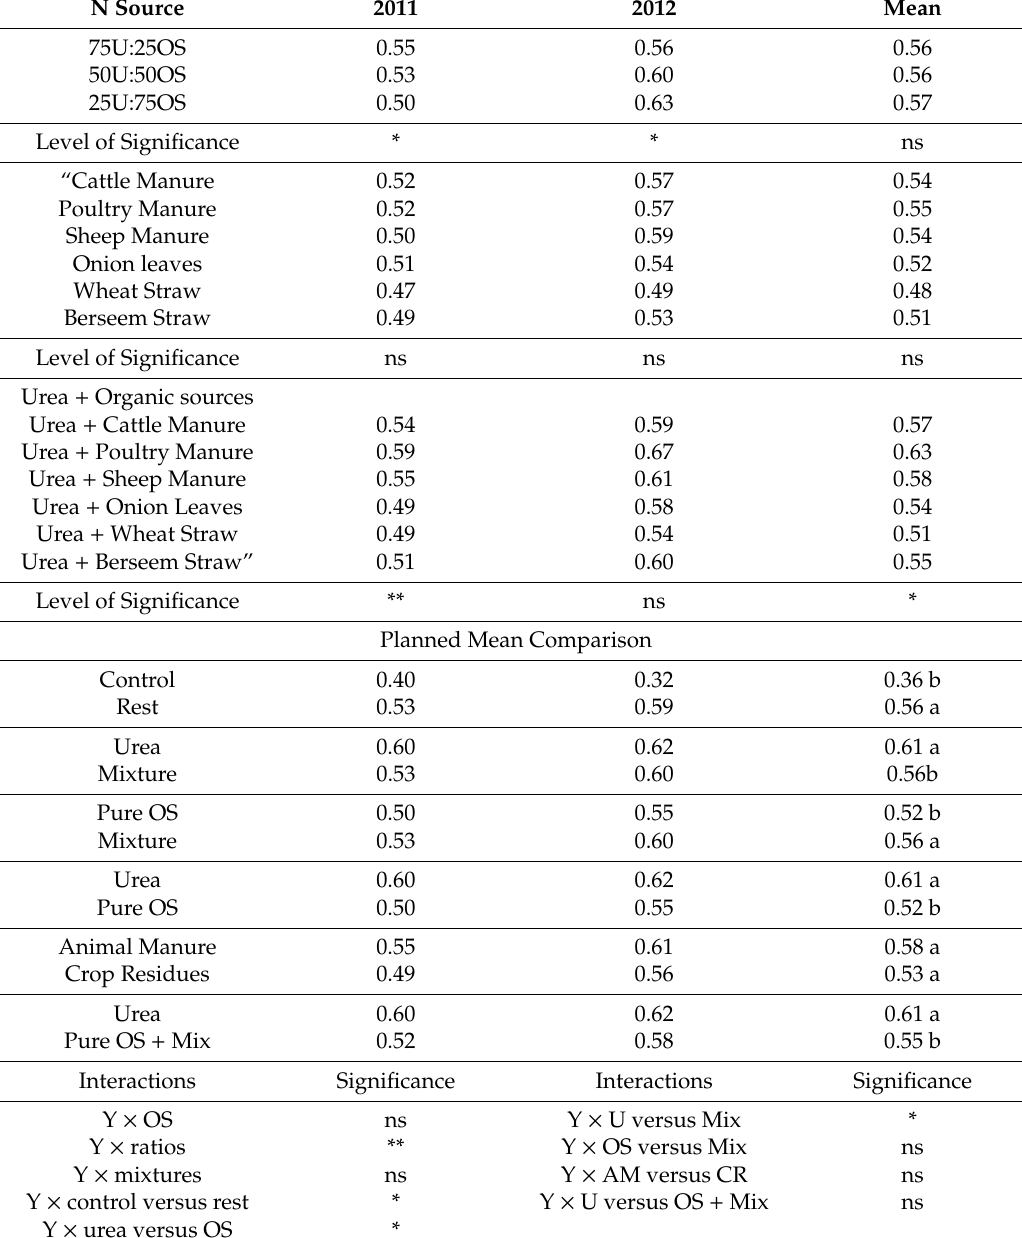
Table 6. Nitrogen concentration in straw (%) of rice hybrid “Pukhraj” as a ff ected by organic and inorganic